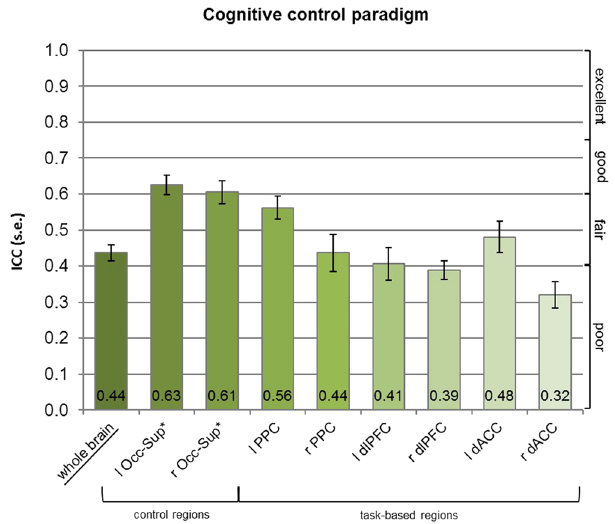
Figure 3. Results of ICC analyses for the cognitive control paradigm. * These regions are based on anatomical masks (AAL). l – left, r – right, Occ-Sup – Superior occipital lobe, PPC – Posterior parietal cortex, dlPFC – Dorsolateral prefrontal cortex, dACC – Dorsal anterior cingulate